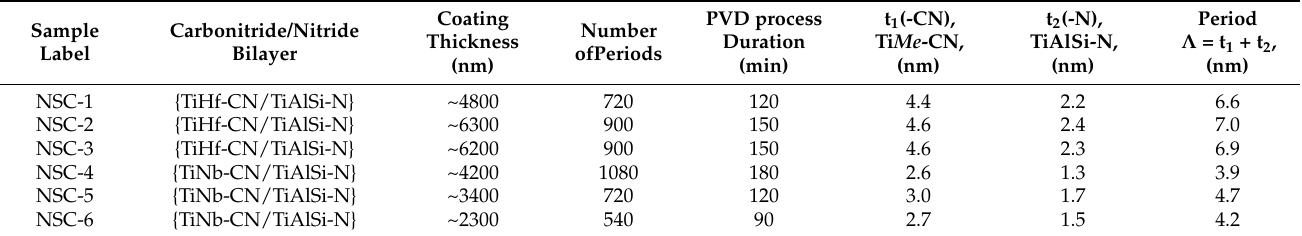
Table 1. A brief characterization of the superlattice periodic structure of the NSC samples: the total coating thickness, periodicity, and thickness of the carbonitride/nitride bilayers, t 1 /t 2 , are shown. Sample